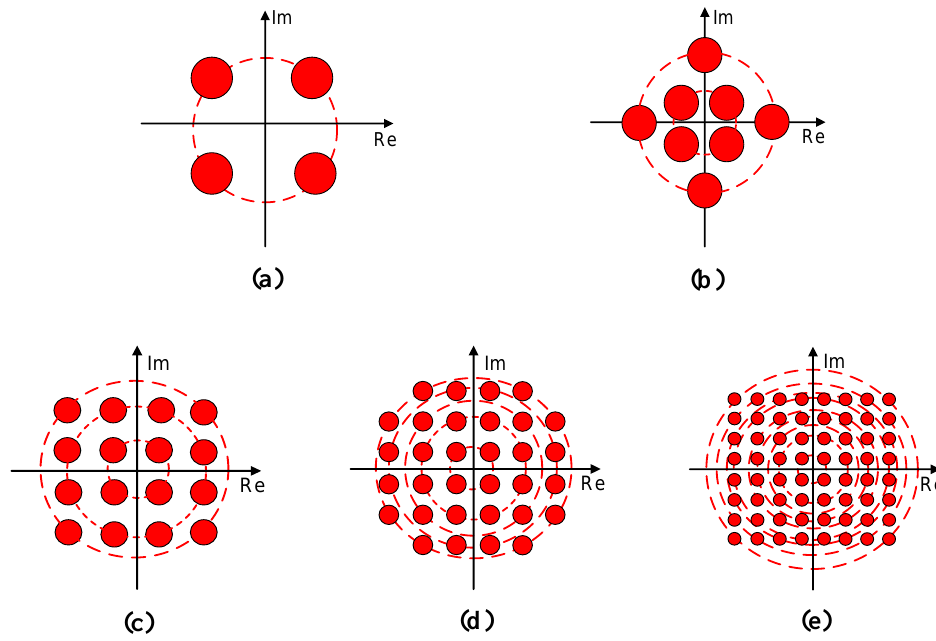
where Z n is the amplitude value, p n is the associated probability for the n - th level, and m is the number of total levels for the considered modulation format. The amplitude levels of the different modulation formats can be clearly seen in Figure 2. However, in practical transmission systems, the distributions of the amplitude levels may be indistinct, even if CD, timing-jitter, and partial polarization mixing are compensated for using the modulation format independent algorithms. As such, it could be difficult to identify high- order modulation formats, especially in low OSNR cases. To address this challenge, the amplitude histogram of the CMA-equalized signals was employed to identify these five modulation formats over a considerably widened OSNR range.